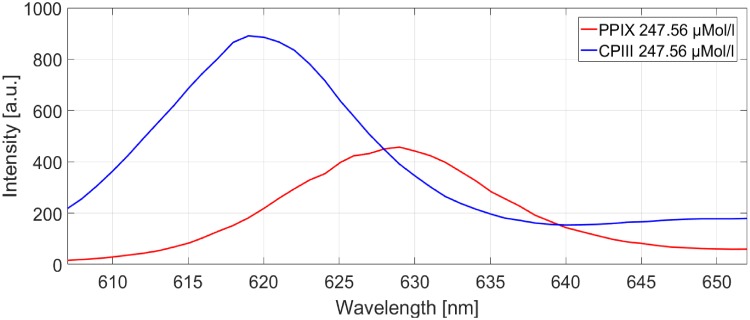
Position of the main peaks of the two porphyrin stem solutions.Measured at pH 7.4 and a concentration of 247.56 μMol/l.